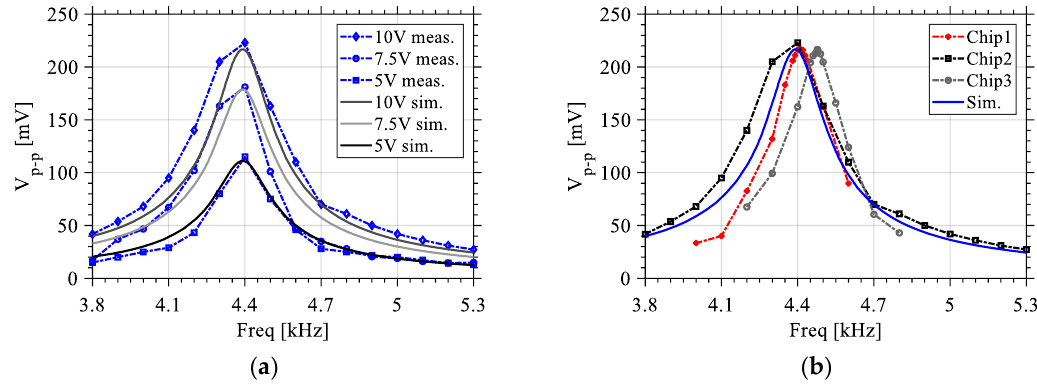
Figure 16. ( a ) Measured output voltage of Design 1 while varying the piezo speaker excitation voltage; and ( b ) variation between different dies of Design